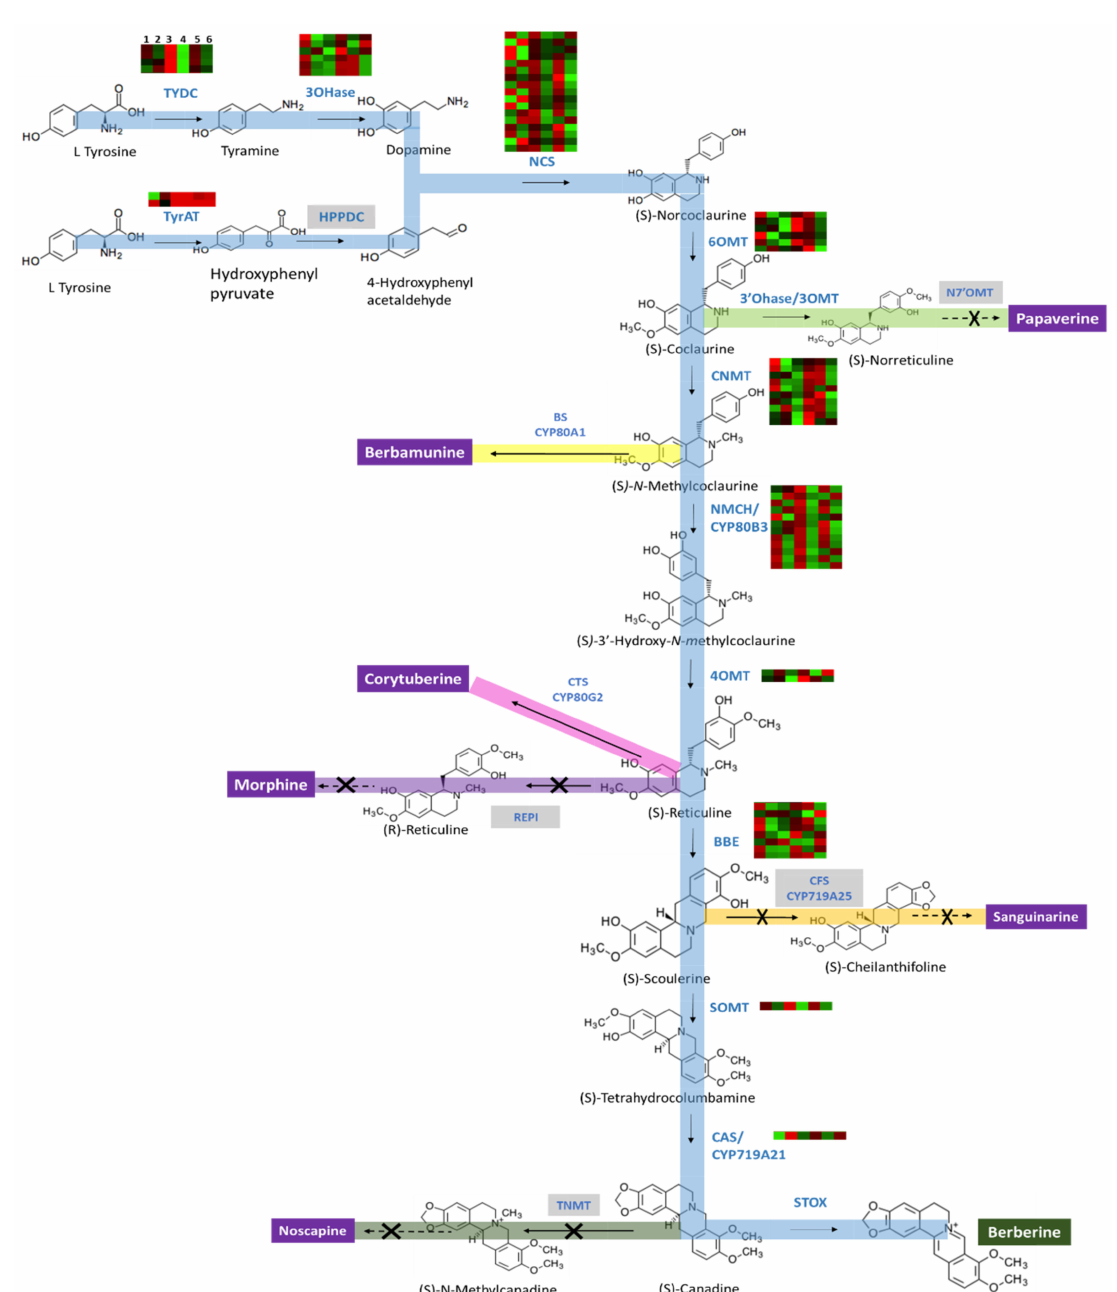
Figure 1. Berberine biosynthesis pathway in B. koreana . Enzymes expression patterns are indicated at the side of each step with the value of log fold change. The expression pattern of each unigene is shown within six column grids, with the left to right in the following order, (1) leaf, (2) flower, (3) young leaf, (4) mature leaf, (5) young fruit, and (6) mature fruit. Genes for enzymes in the grey boxes were not found in B. koreana. Solid arrows indicates single step reaction and dashed arrows indicate multiple step reaction. Crossed arrow represents the reaction is terminated in that